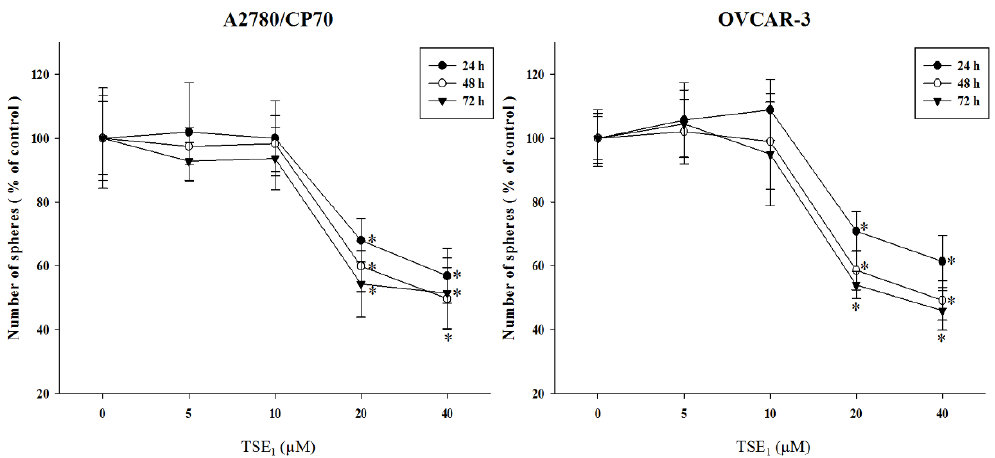
Figure 6. Effects of TSE 1 on sphere formation of sphere cells (3-weeks) from A2780/CP70 and OVCAR-3 cell lines. TSE 1 suppressed the sphere forming viability of sphere cells with treatment 0 to 40 µM for 24, 48 and 72 h, respectively. Data was expressed as percent of control (without TSE 1 treatment) and shown as mean ± SD ( n = 5), * = p ≤ 0.05, significant difference compared to control at the same treatment time.